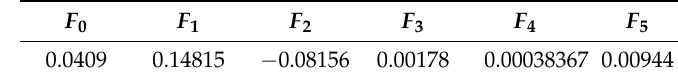
. ε * ( b ). . ε * (cid:1) (cid:0) ε ,ln